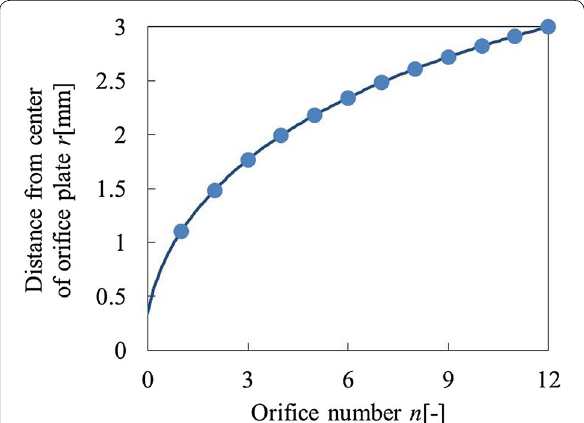
Fig. 8 Relationship between orifice number and distance from center of orifice plate